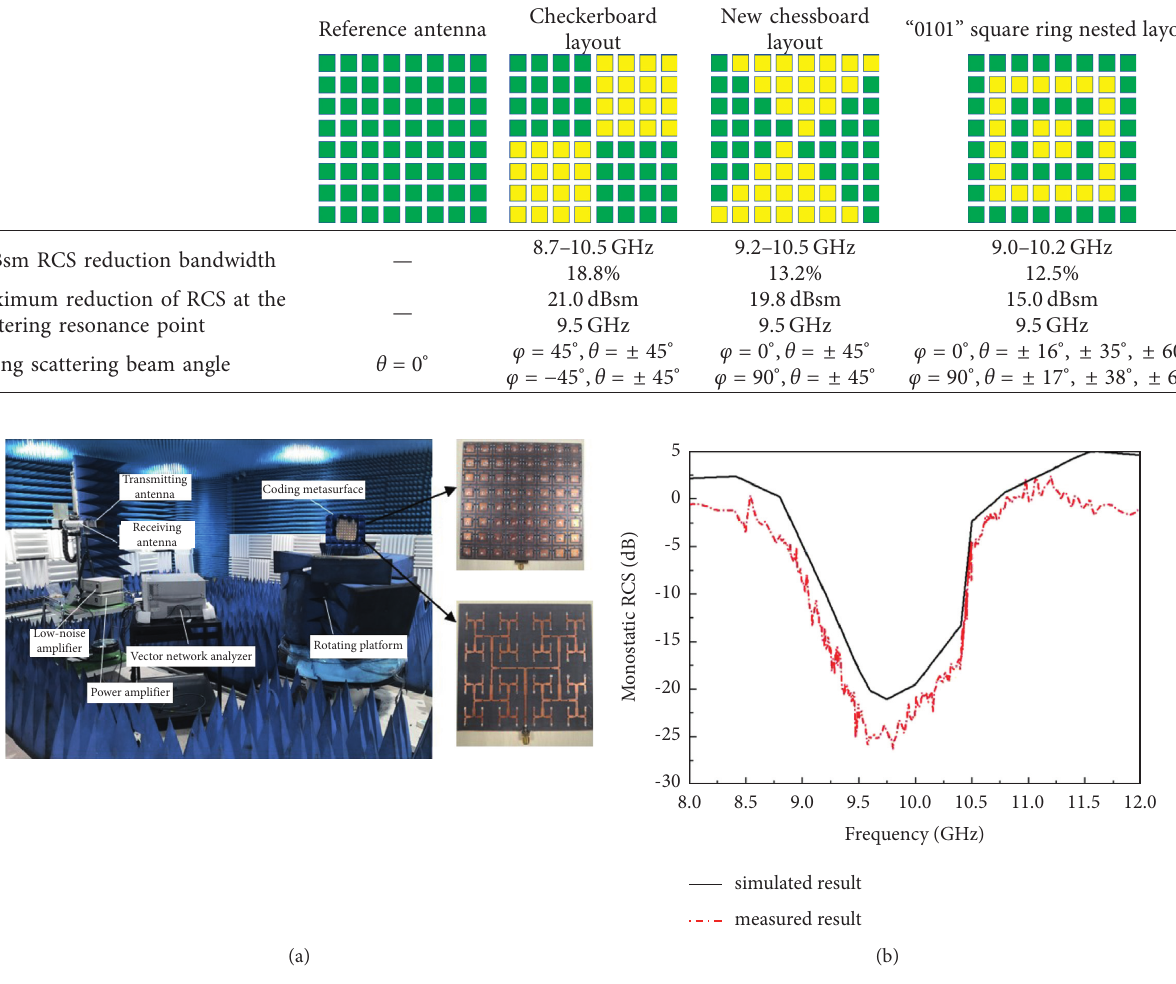
Figure 9: Measured scattering performance; (a) RCS measured environment; (b) measured monostatic RCS results.